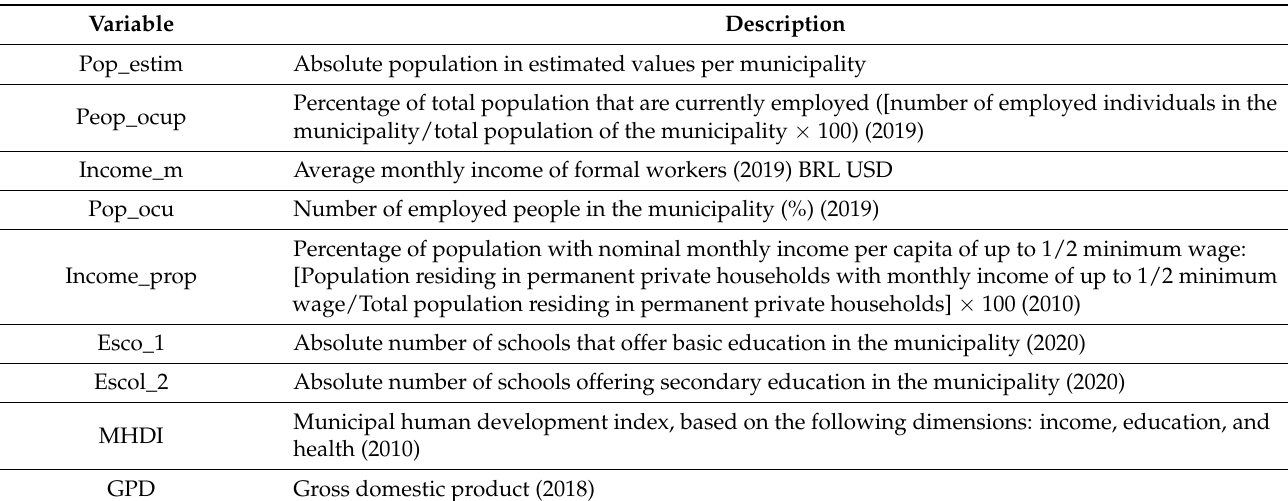
Table 2. Attributes used in the